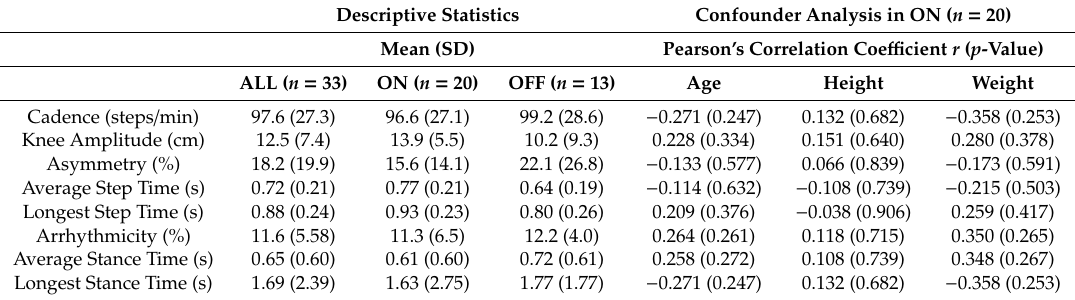
Table 3. Descriptive statistics for SIP parameters on the left for the whole sample and subset of recordings in ON and OFF treatments states, and on the right, estimation of confounding e ff ects of age, height, and weight in the subset of recordings in ON.